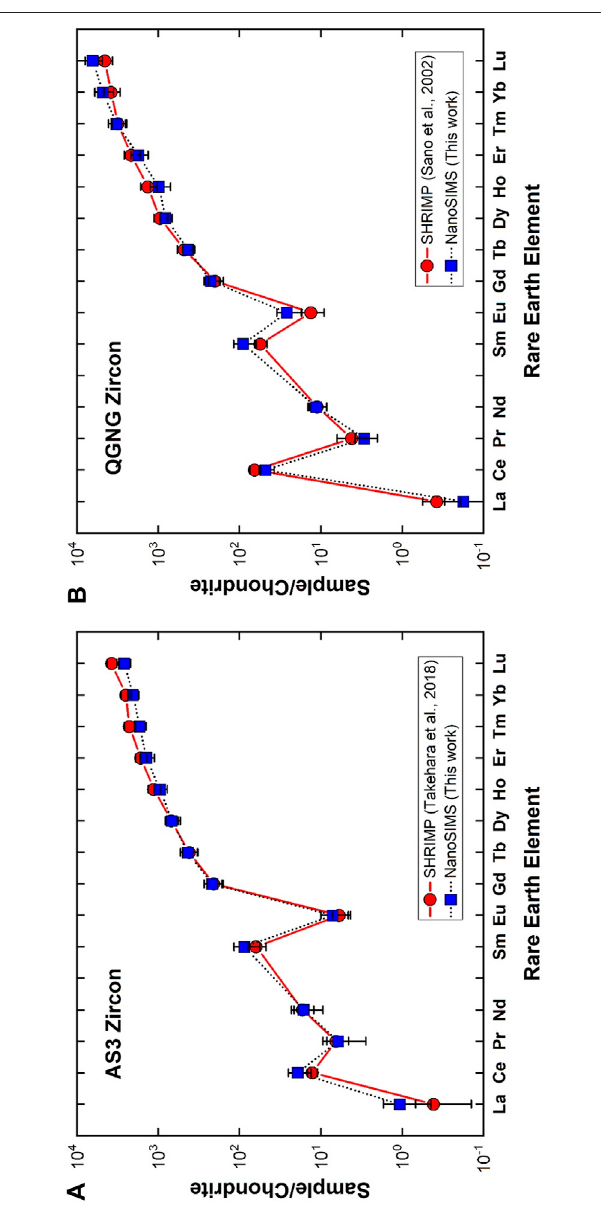
FIGURE 3 | Chondrite normalized rare earth elemental abundances in (A) AS3 zircon and (B) QGNG zircon. Error assigned to the symbol is 2 σ . A solid circle is from Takehara et al. (2018) measured by SHRIMP in NIPR, while asolidsquareindicatesdataofSanoetal.(2002)analyzedbySHRIMPin